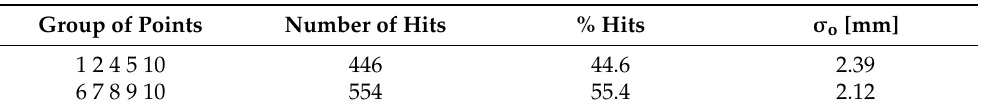
Table 3. Results of identification of the stability of reference system by the simulated annealing method for the test object 1.